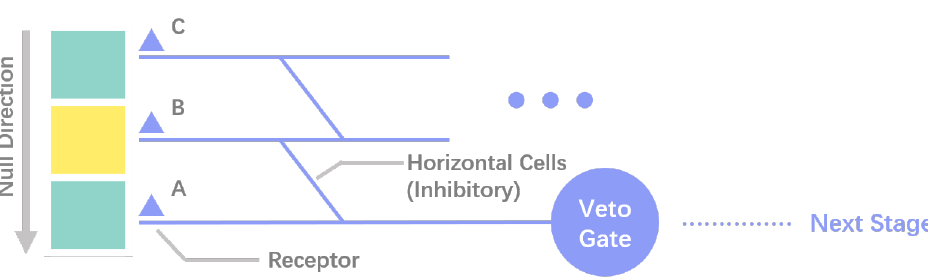
Figure 1. Barlow’s inhibitory scheme for the directional selectivity of ganglion cells. In the left part of the pattern, a light spot (yellow) is traveling across the receptive field (blue). A, B and C are receptors. Response will be delayed when it passes horizontal cells. The veto gate offers Vote operations.